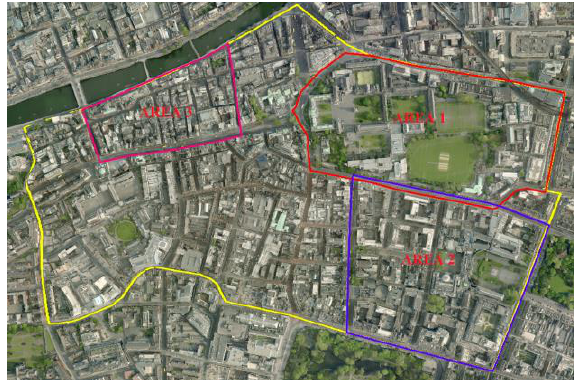
Figure 2. Designation of the three contest areas